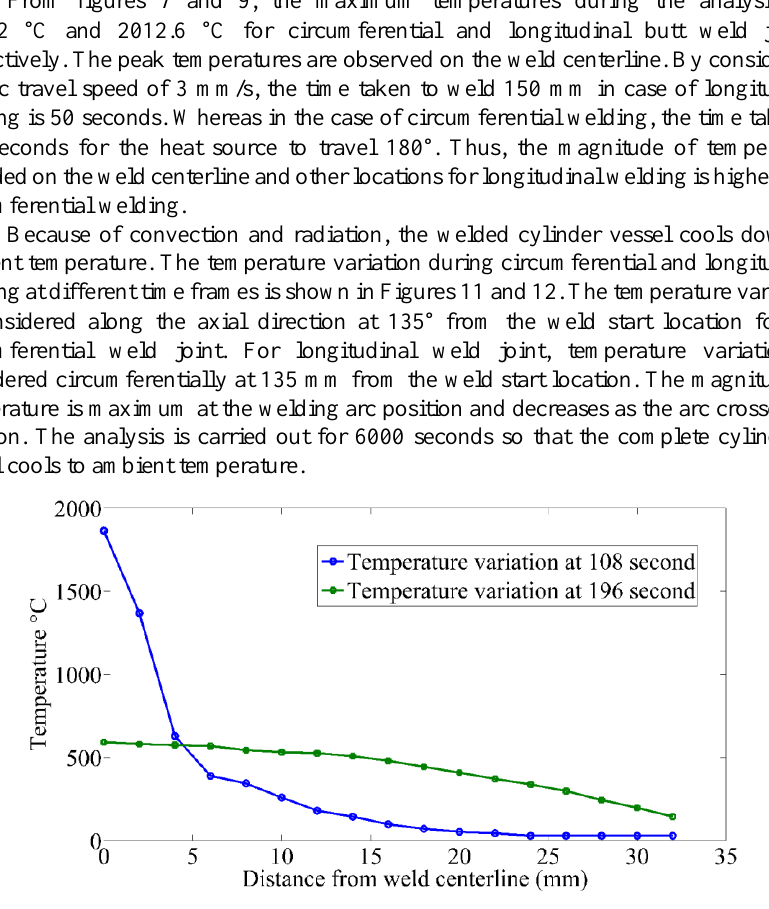
Fig. 11. Temperature variation in the circumferential weld joint at different time